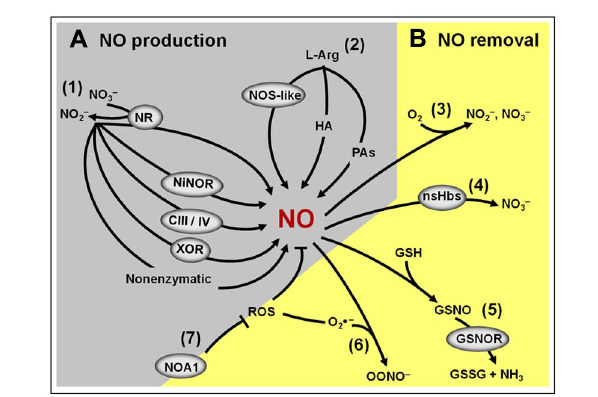
FIGURE 3 | Overview of the NO production and removal mechanisms in plants. (A) Main components of the NO biosynthetic machinery: (1) Nitrite-dependent NO production in plants includes a non-enzymatic pathway and several enzymatic pathways involving the action of cytosolic and plasma membrane nitrate reductases (NR), nitrite–NO reductase (NiNOR), mitochondrial electron transport chain (CIII/IV) and xanthine oxidoreductase (XOR). (2) L -Arginine-dependent NO production pathway involves a non-identified nitric oxide synthase (NOS)-like enzyme and two still poorly characterized pathways using hydroxylamine (HA) or polyamines (PAs) as substrates. (B) Main components of the NO removal machinery: (3) the reaction of NO with molecular oxygen leads to the spontaneous production of nitrite and nitrate. (4) NO can react with non-symbiotic hemoglobins (nsHbs) resulting in nitrate formation. (5) Alternatively, NO may react with reduced glutathione (GSH) to form S -nitrosoglutathione (GSNO), which, in turn, can be converted into oxidized GSSG and ammonia by the action of GSNO reductase (GSNOR). (6) NO can also react with superoxide ( O − 2 ), resulting in the formation of peroxynitrite (OONO − ). (7) By influencing the production of reactive oxygen species (ROS), NO-ASSOCIATED 1 (NOA1) protein indirectly impacts NO levels in